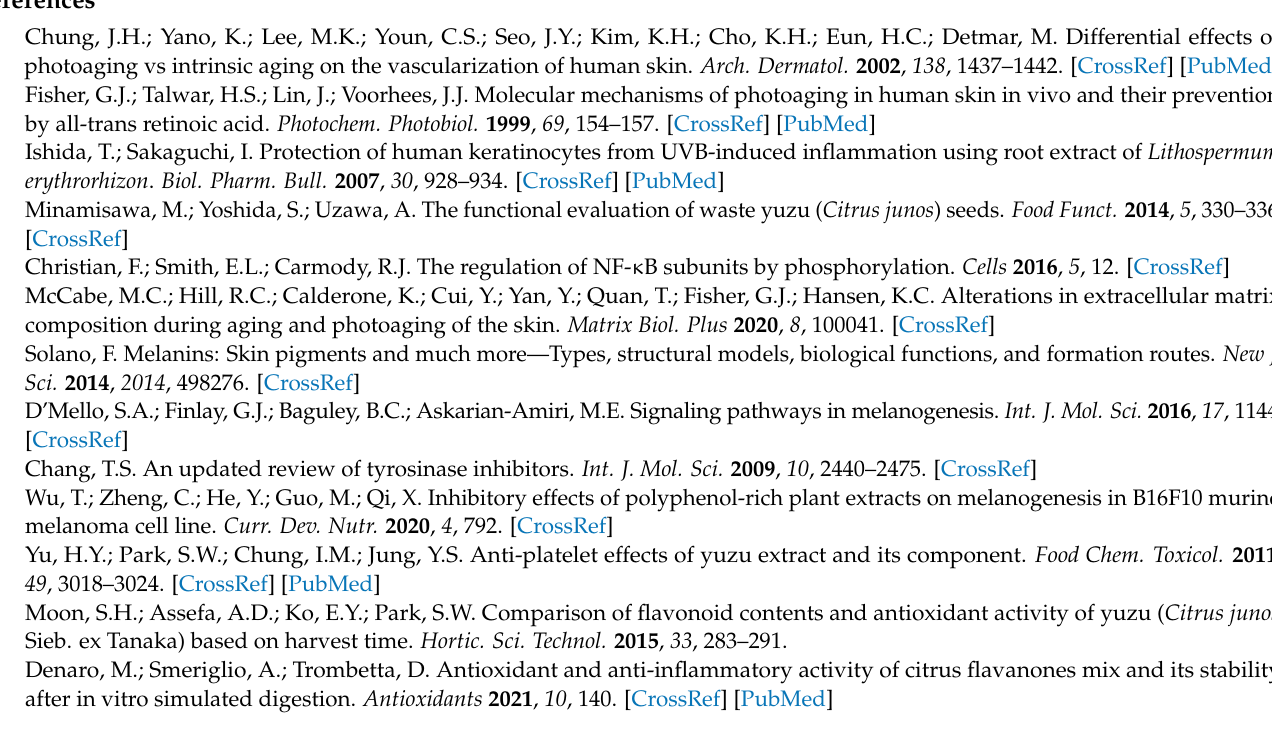
Figure S2: 13 C-NMR spectrum of nomilin; Figure S3: Antioxidant activity profiles of LA1, LA2, LA3, LG1, LG2, and LG3. (a) DPPH radical scavenging activity and (b) ABTS radical scavenging activity; Figure S4: HPLC chromatogram of limonoid aglycones (LA1, LA2, and LA3) and limonoid glucosides (LG1, LG2, and LG3) using diode-array detection at 220 nm. (a) LA1; (b) LA2; (c) LA3; (d) standard mixture (1: limonin, 2: nomilin); (e) LG1; (f) LG2; (g) LG3; (h) standard mixture (1: chlorogenic acid, 2: caffeic acid, 3: rutin, 4: p -coumaric acid, 5: naringin, 6: hesperidin, 7: luteolin, 8: linoleic acid); Table S1: HPLC conditions used for the identification of limonoid aglycones and limonoid glucosides; Table S2: Phenolic compounds identified in limonoid aglycone extracts quantified by HPLC; Table S3: Phenolic compounds identified in limonoid glucoside extracts quantified by